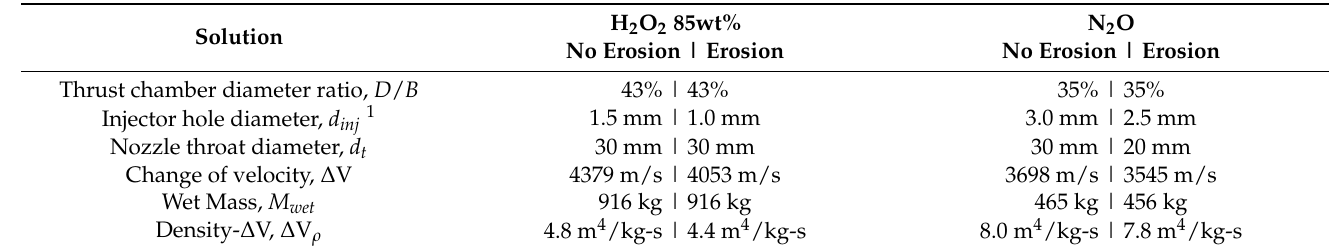
Table 6. Summary of best